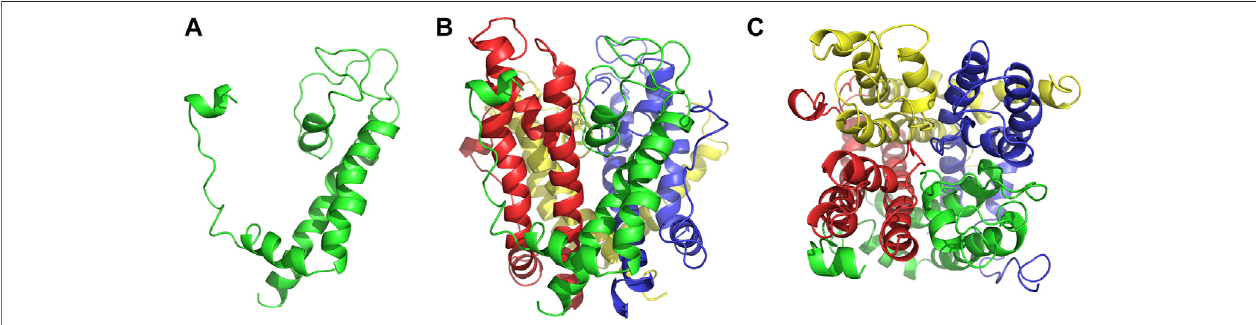
FIGURE2 | Simulated 3D structure ofthetransmembrane regionof theKv1.5 channel. (A) Asingle subunit ofthe transmembraneregion ofKv1.5 viewed from the side. (B) FoursubunitsofthetransmembraneregionofKv1.5viewedfromtheside. (C) FoursubunitsofthetransmembraneregionofKv1.5viewedfromtheextracellular side of the pore. The subunits are represented as ribbons and colored individually.